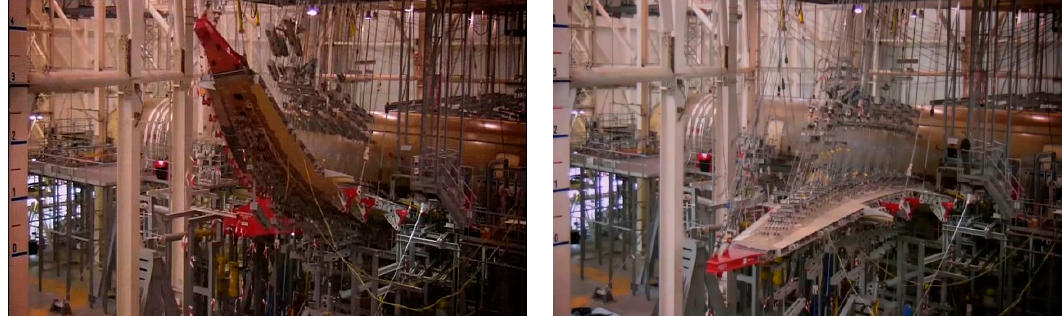
Figure 12. Detection of structural deformation through strain gages.